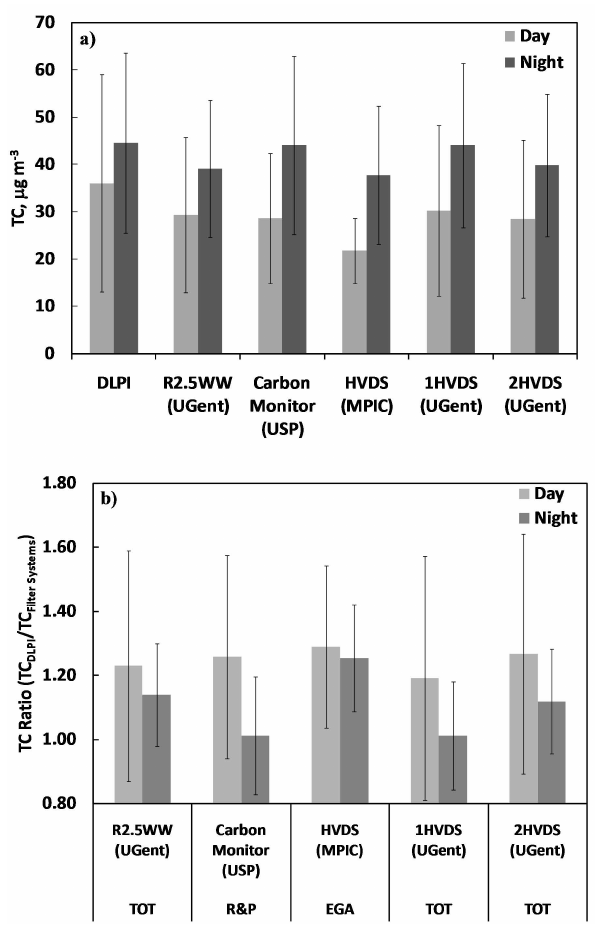
Fig. 4. (a) TC concentration averages ( D p < 2 . 5µm) for DLPI (UPR) and R2.5WW (UGent), carbon monitor (USP), HVDS (MPIC), 1HVDS (UGent), 2HVDS (UGent)) together with the stan- dard deviation bars for day and night time samples. The number of samples used for each system were: DLPI (UPR) – n = 3; R2.5WW (UGent), carbon monitor (USP), HVDS (MPIC), 1HVDS (UGent), 2HVDS (UGent)) – n = 37. (b) TC concentration ratio of the dif- ferent filter systems relative to the DLPI ( D p < 2 . 5µm) for day and night time. The error bars presented here were calculated by using the error propagation rules.